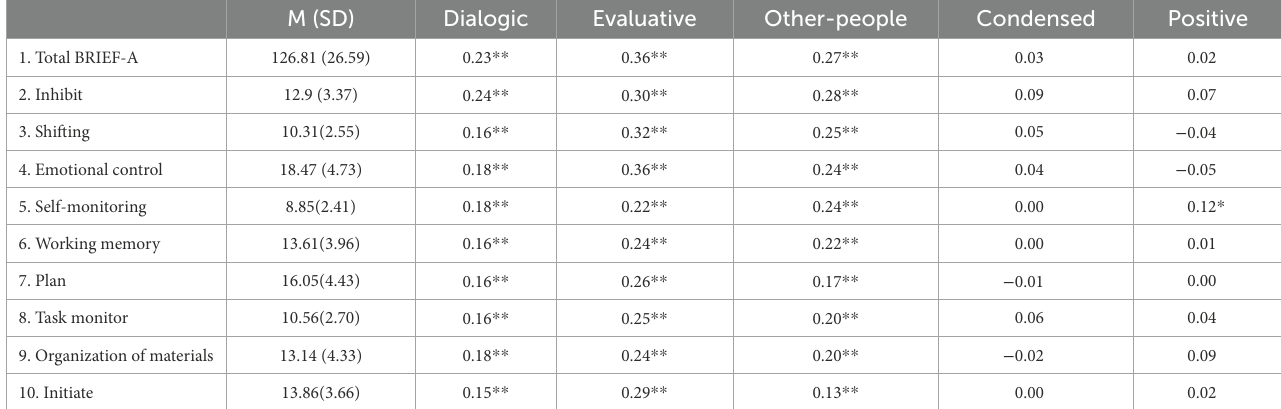
TABLE 2 Correlations of the VISQ-R subscale-scores with BRIEF-A scores ( n =